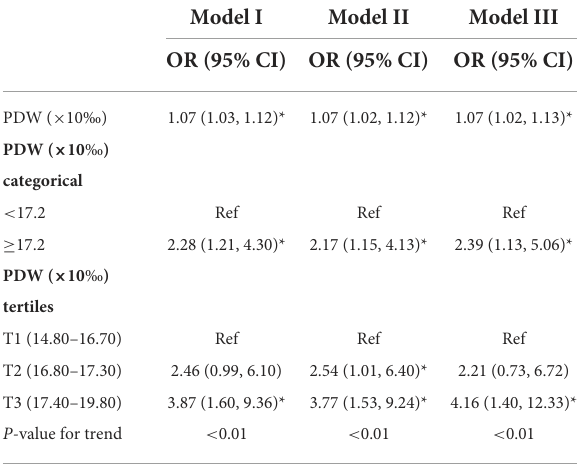
TABLE 2 Multivariable regressions analysis in different models.